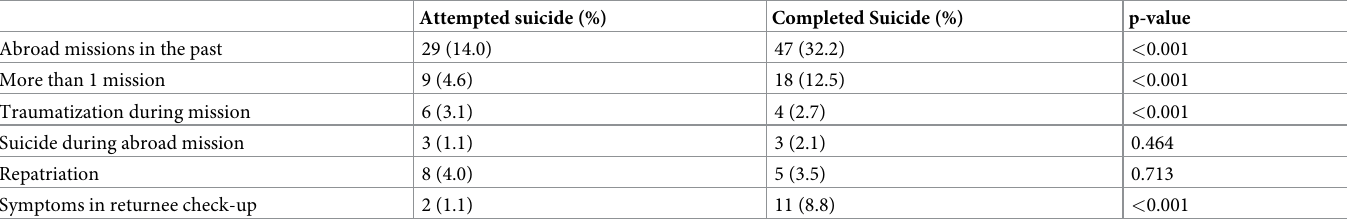
Table 4. Deployment